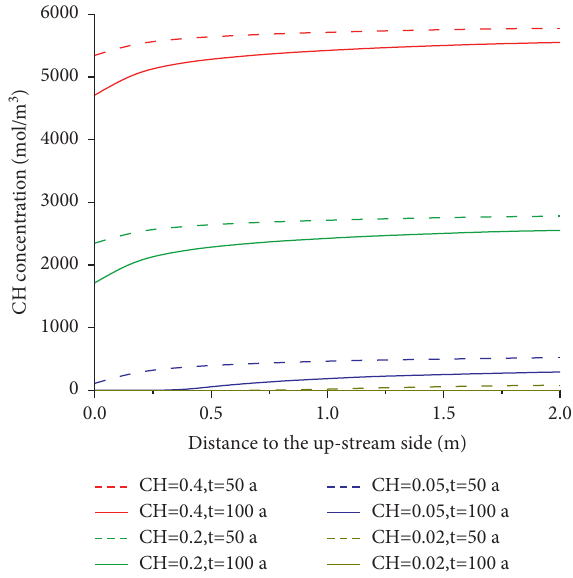
Figure 20: CH concentration curves of grout curtain with different initial CH contents. Figure 21: Hydraulic conductivity curves of grout curtain with different initial CH